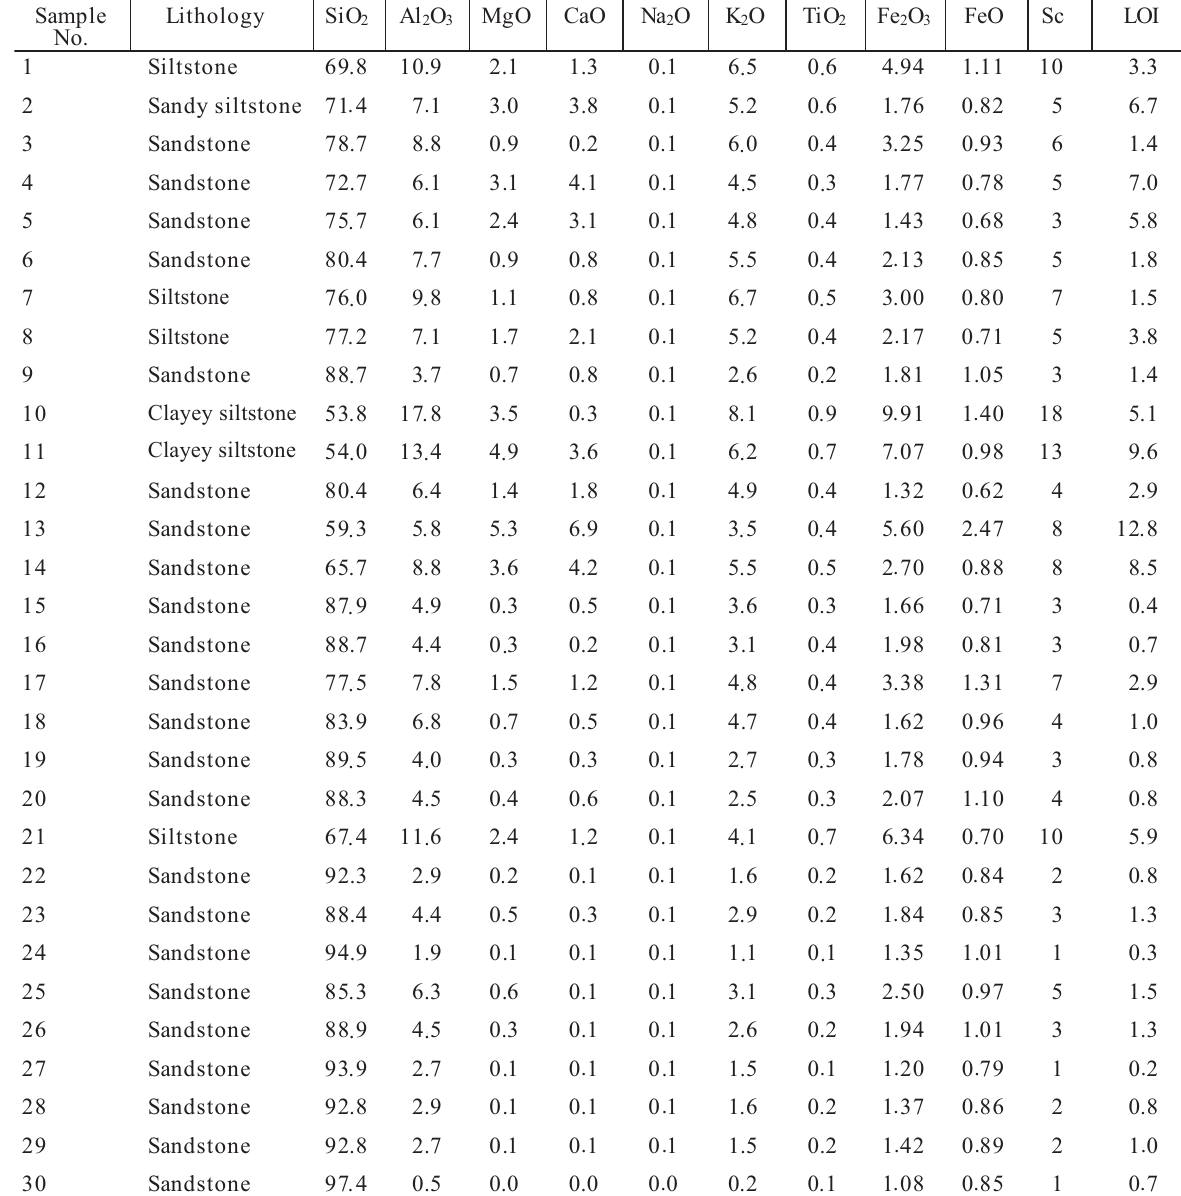
Table 2. The results of the chemical analyses of the rock samples. Units – %, Sc – ppm. The numbering of the rock samples is in accordance with Table